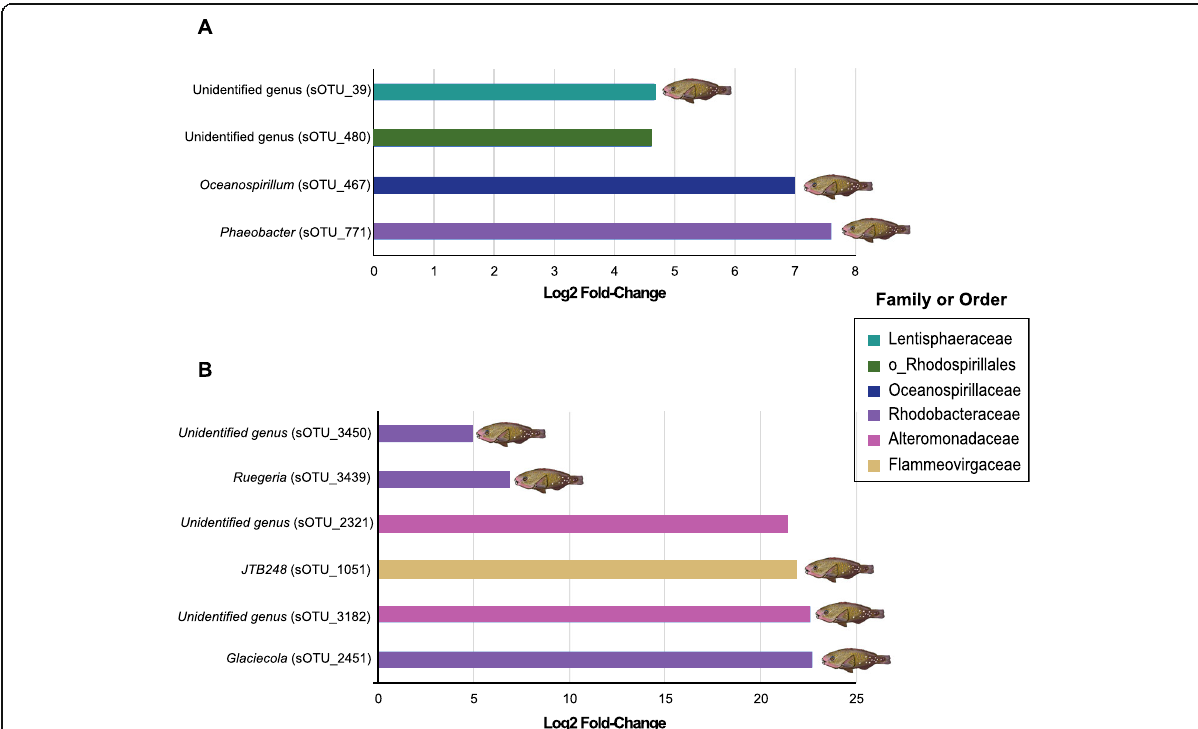
Fig. 4 Differential abundance analysis (DESeq2) illustrating the sOTUs labeled as genera and families or order that differed significantly between ( a ) predated and mechanically wounded corals for the mesocosm experiment at T f (48 h) and ( b ) naturally unbitten and bitten corals in the field survey. Fish illustration indicates the presence of the corresponding taxa in parrotfish mouths (image credit: Katrina